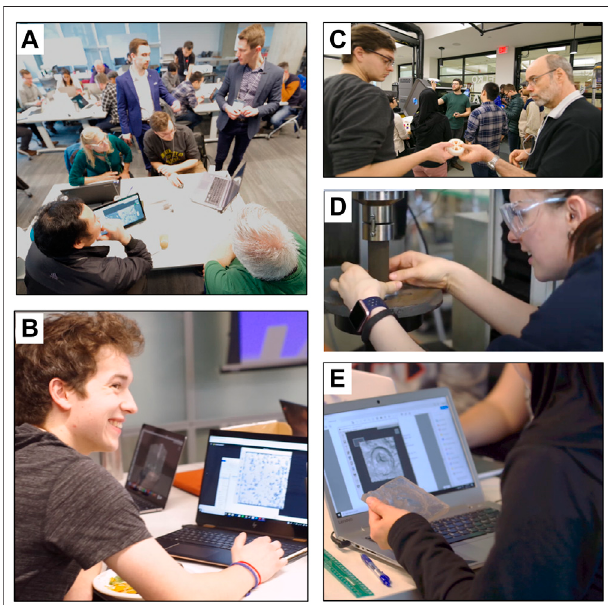
FIGURE 3 | Photographs of the short course modules. (A) Module 1 “ Overview of the 3D printing technology. ” Course instructors presented a lecture on common additive manufacturing methods and materials and showed examples of 3D-printed models. (B) Module 2 “ The art of making 3D-printable models. ” Participants learned basic skills of CAD modelingusing TinkerCAD. (C) Module 3 “ Elko Garage Tour. ” Live 3D printing process was shown to participants. (D) Module 4 “ GeoPrint Tour. ” Participants were shown industrial scale printing and experimental program performed with3D-printedmodels. (E) Module 5 “ Application of3Dprinting in the geoscience. ” Discussion of speci fi c applications of geoscience models in edication and